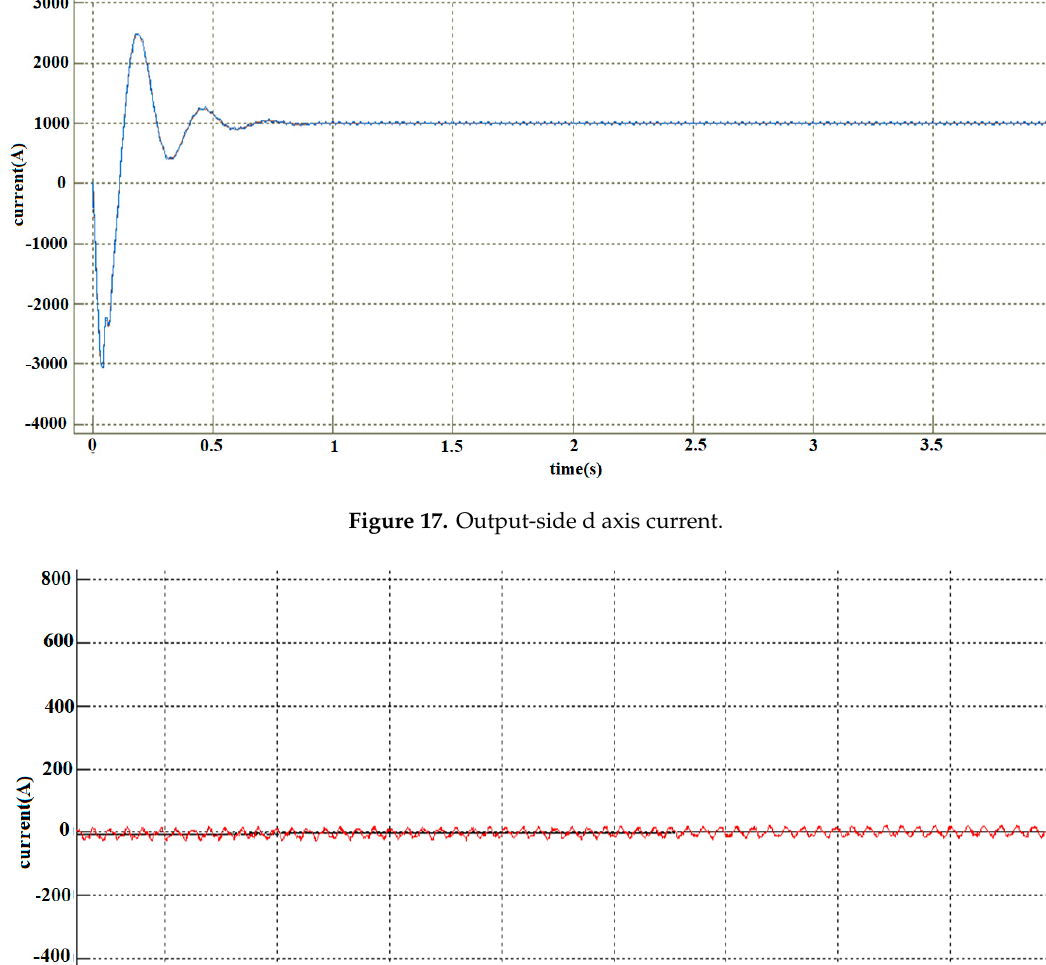
Figure 16. Input-side current tracking of q axis.